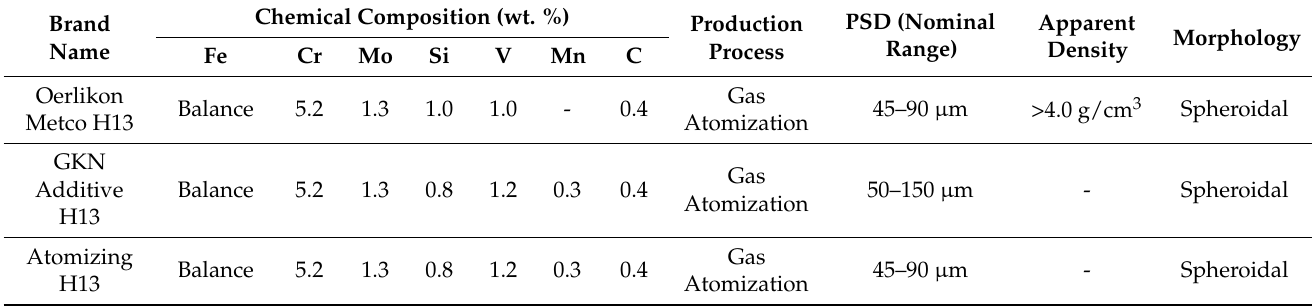
Table 1. AM metal powder characteristics provided by producers’